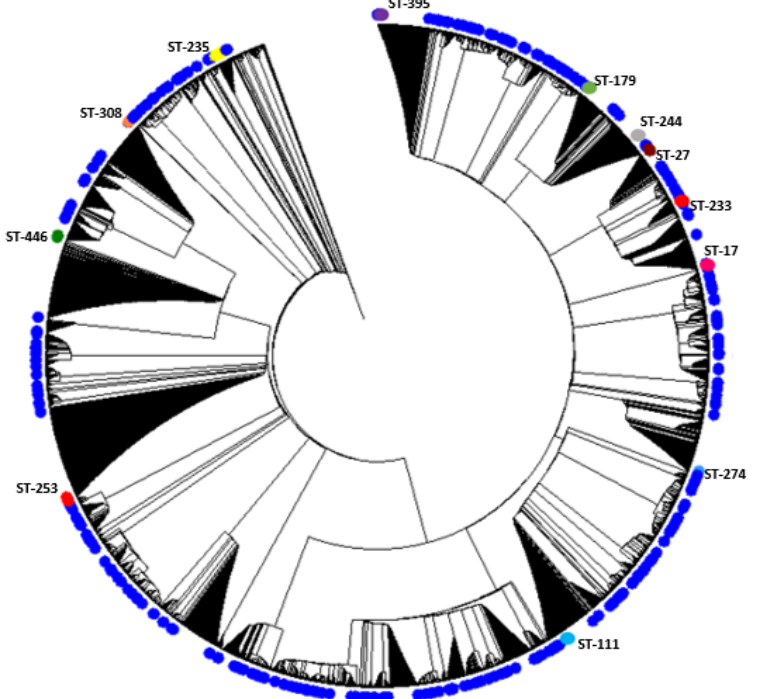
Figure 1. Hierarchical clustering showing the distribution of analyzed sequences among all known Sequence Types STs. Blue circles indicate the position of the studied sequences among all other P. aeruginosa sequences. The positions of high-risk clones are also shown on the figure using different colors.